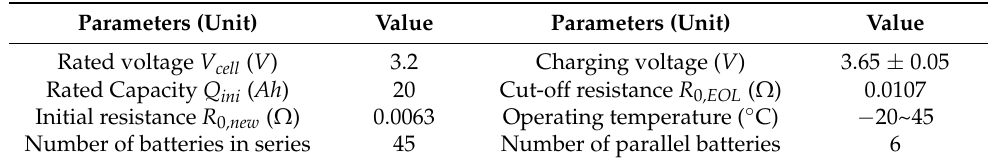
Table 2. Battery